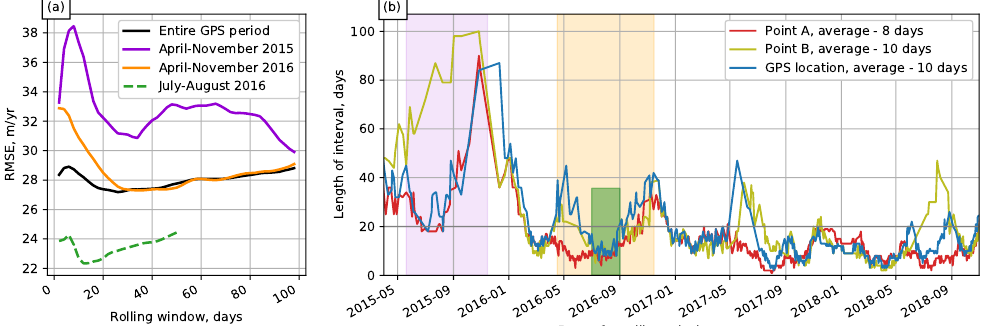
Figure 12. ( a ) Root-mean-square error (RMSE) between ice velocity from satellite and GPS as a function of the moving average’s window size applied to the GPS data. The RMSE is calculated for the entire GPS period (black) and for time subsets of April to November 2015 (purple), April to November 2016 (orange), and July to August 2016 (dashed green). ( b ) Time length of LOWESS subset calculated for points having the weights greater than 0.5 versus point’s date fitted by this subset for three locations indicated on Figure